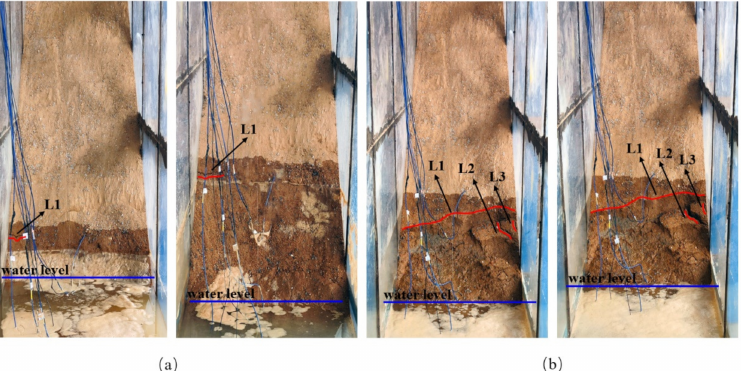
Figure 9. Failure characteristics of the accumulation layers during ( a ) the first and ( b ) the second phase of the test.